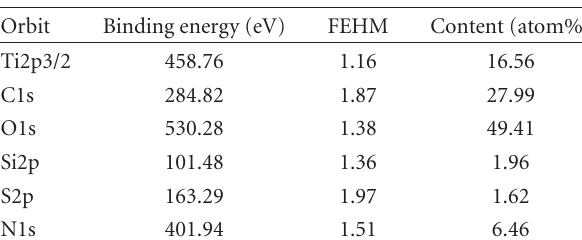
Table 1: XPS data for APTCPP-MPS-TiO 2 .